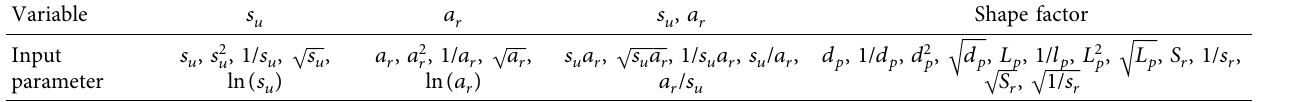
Table 5: Various types of input variables for MLR modeling in approach 2.